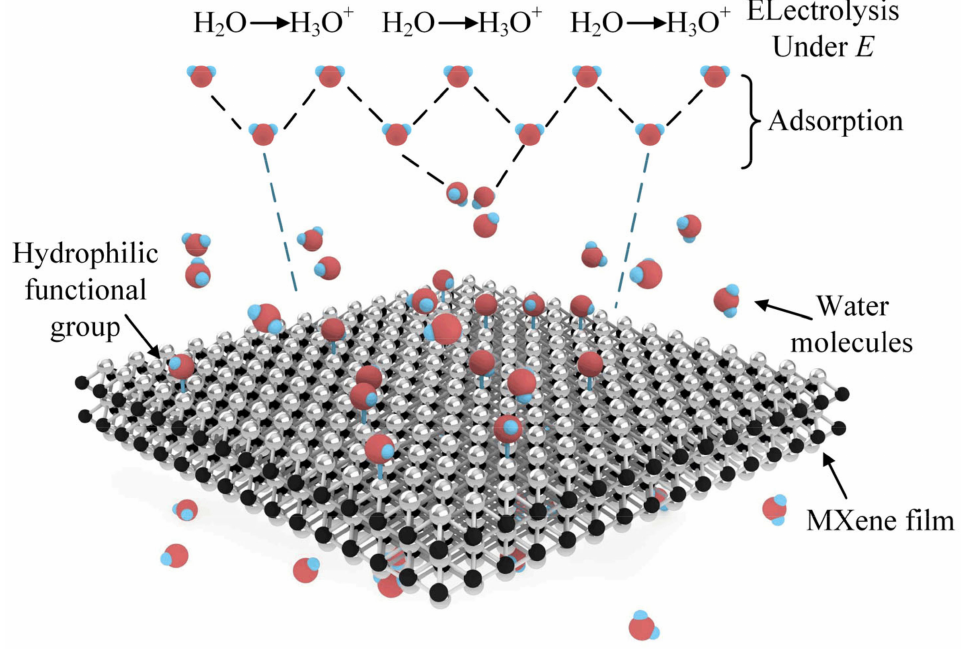
Figure 9. Schematic diagram of adsorption of water molecules on the